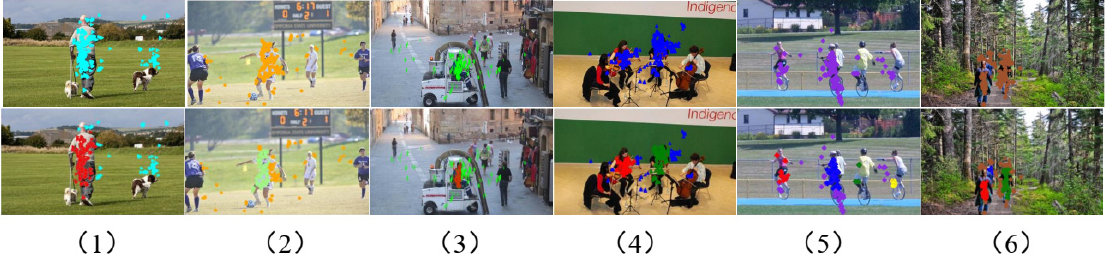
Figure 11. Result of gaze point classification. ( 1 )–( 6 ) is the number of the images, these number are used in Figure 12.